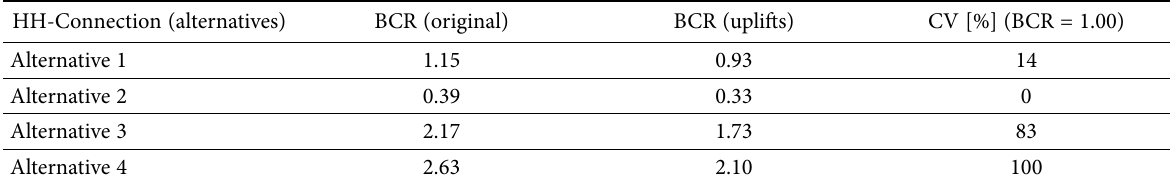
Table 7. Results from a stochastic run in the UNITE-DSS model applying the RCF-technique with respect to inaccuracies in demand forecasts HH-Connection